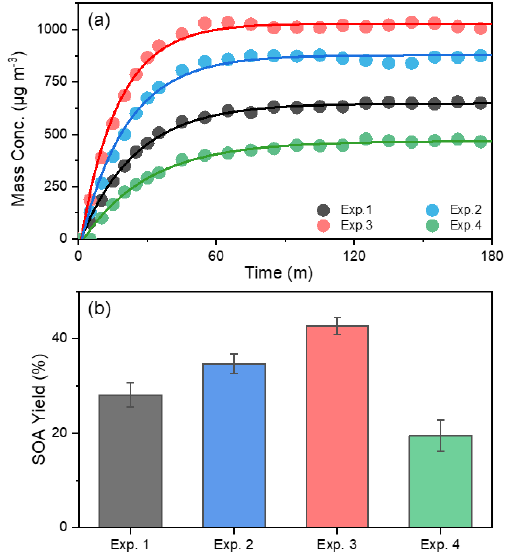
Figure 1. The evolution of mass concentration (a) and yield (b) of toluene-derived SOA in different experiments. All the mass concen- trations were wall-loss corrected. The error bars were calculated by the fluctuation of measured SOA concentration after the UV light was turn off at the end of each